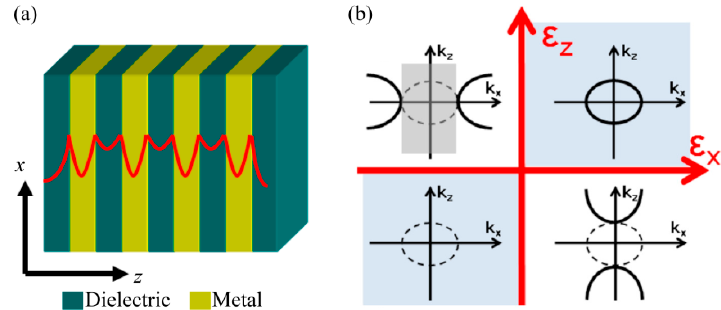
Figure 4. ( a ) Schematic of BPPs (plasmon polaritons) in hyperbolic metamaterial with alternative stacked metal–dielectric nano films; ( b ) Dispersion relation of the multilayer films with different signs of ε x and ε z . Reproduced from [34]. Copyright © 2014, AIP.